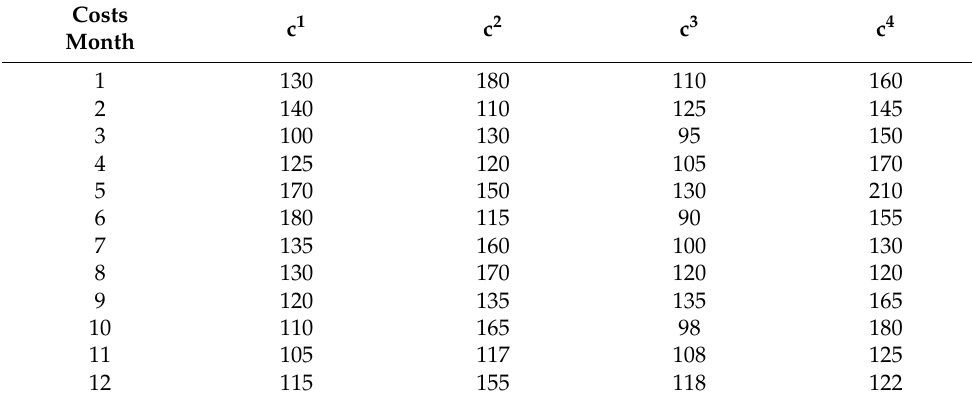
Table 4. Costs (in BGN) for inventory management for the previous